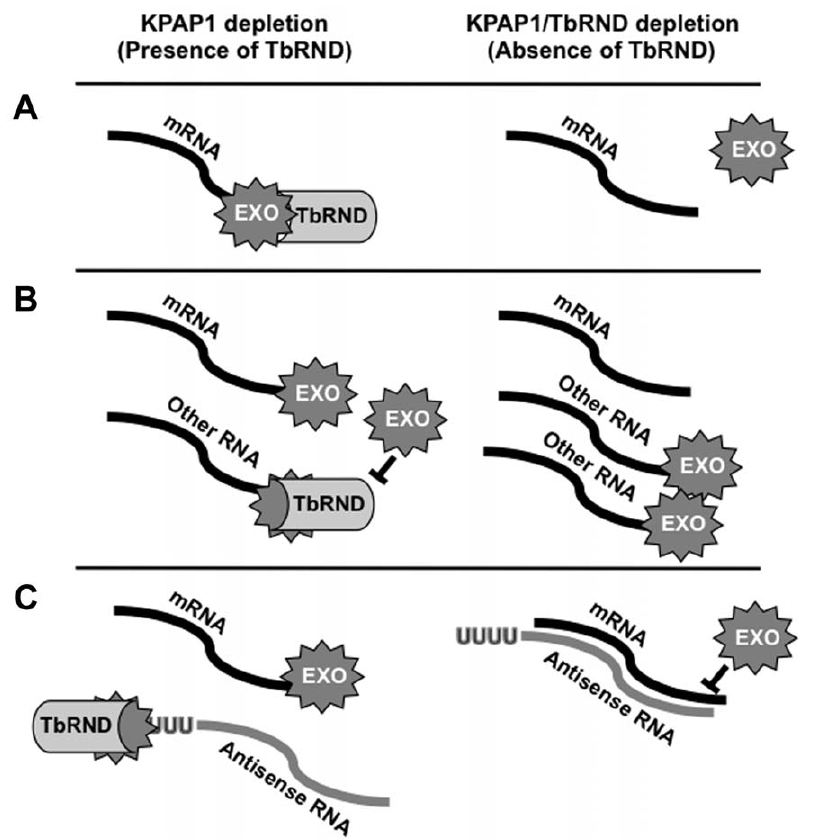
Figure 6. Three models explaining indirect stabilizing effects of TbRND depletion on mRNAs in a KPAP1-depleted background. A. TbRND recruits exoribonucleases to nonadenylated transcripts. B. Upon TbRND/KPAP1 co-depletion, RNAs that are normally targets of TbRND build up and generally dilute the effects of mitochondrial ribonucleases on other transcripts, thus stabilizing them. C. TbRND degrades uridylated antisense transcripts that stabilize an mRNA.